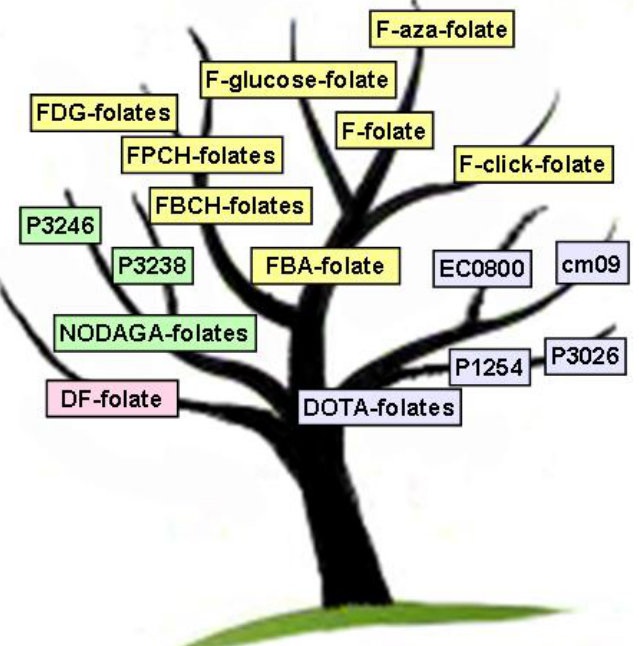
Figure 1. ―Folate-Tree‖—evolution of folate-based PET agents for 18 F-labeling (yellow) and for radiometallation using variable chelators (pink: DF = deferoxamine; green: NODAGA = 1,4,7-triazacyclononane,1-glutaric acid-4,7-acetic acid; blue: DOTA = 1,4,7,10-tetraazacyclododecane- N,N',N'',N''' -tetraacetic acid) suitable for radiolabeling with 66/68 Ga, 44 Sc or 152